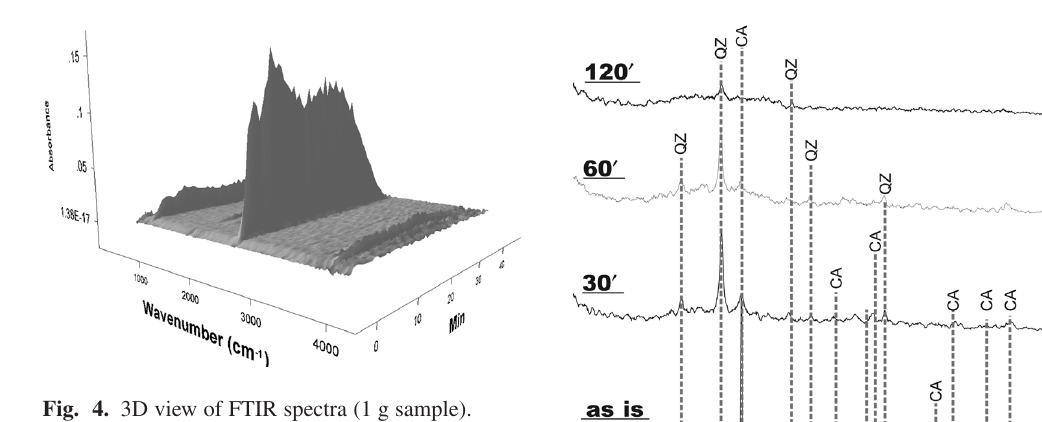
Fig. 4. 3D view of FTIR spectra (1 g sample).